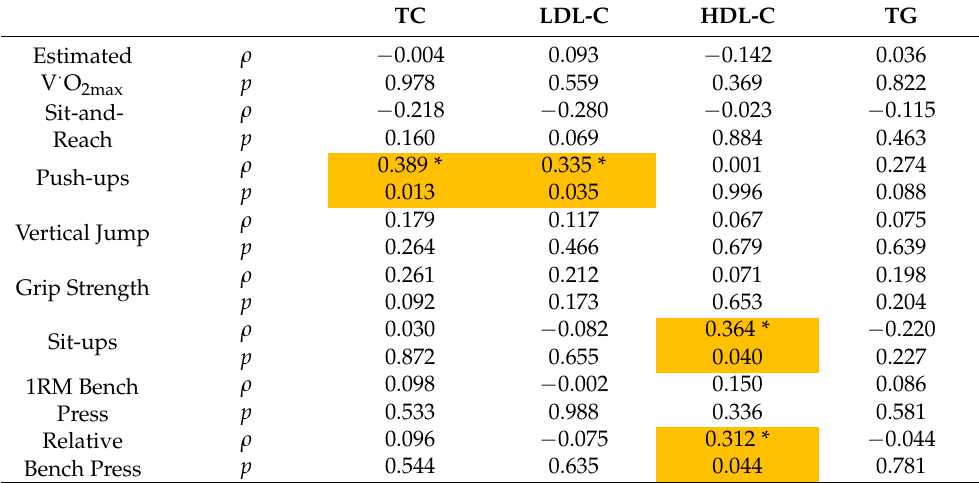
Table 6. Relationships between blood lipids (total cholesterol (TC), low-density lipoproteins (LDL-C), high-density lipoproteins (HDL-C), and triglycerides (TG)) and fitness (estimated maximal aerobic capacity (V · O 2max ), sit-and-reach, push-ups, vertical jump, grip strength, sit-ups, one-repetition maximum (1RM) bench press, and relative bench press) in male police officers ( n = 194) from a health and wellness program in 2019. Significant relationships are highlighted in orange. TC LDL-C HDL-C TG ρ − 0.062 − 0.054 0.118 − 0.163 * Estimated p 0.396 0.465 0.107 0.026 V · O 2max ρ 0.048 0.066 0.141 − 0.083 Sit-and- p 0.505 0.372 0.050 0.254 Reach ρ − 0.063 0.032 − 0.275 * Push-ups <0.001 ρ − 0.124 − 0.046 − 0.006 − 0.163 * Vertical Jump 0.087 0.031 ρ − 0.113 − 0.151 0.155 − 0.222 * Sit-ups p 0.157 0.059 0.051 0.005 ρ − 0.057 0.018 − 0.092 − 0.111 1RM Bench p 0.426 0.808 0.203 0.122 Press ρ − 0.027 0.046 0.061 − 0.188 * Relative p 0.711 0.530 0.401 0.009 Bench Press * Significant ( p < 0.05) relationship between the two variables. Table 7. Relationships between blood lipids (total cholesterol (TC), low-density lipoproteins (LDL-C), high-density lipoproteins (HDL-C), and triglycerides (TG)) and fitness (estimated maximal aerobic capacity (V · O 2max ), sit-and-reach, push-ups, vertical jump, grip strength, sit-ups, one-repetition maximum (1RM) bench press, and relative bench press) in female police officers ( n = 43) from a health and wellness program in 2019. Significant relationships are highlighted in orange. TC LDL-C HDL-C TG ρ − 0.004 0.093 − 0.142 0.036 Estimated V · O 2max ρ − 0.218 − 0.280 − 0.023 − 0.115 Sit-and- 0.160 0.463 Reach ρ 0.389 * Push-ups Vertical Jump